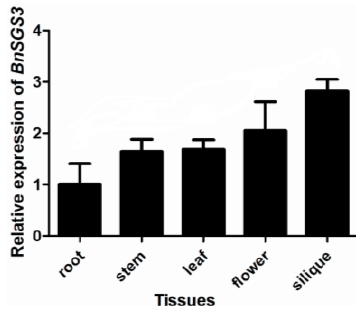
Figure 2. Relative expression levels of BnSGS3 in different tissues of oilseed rape.